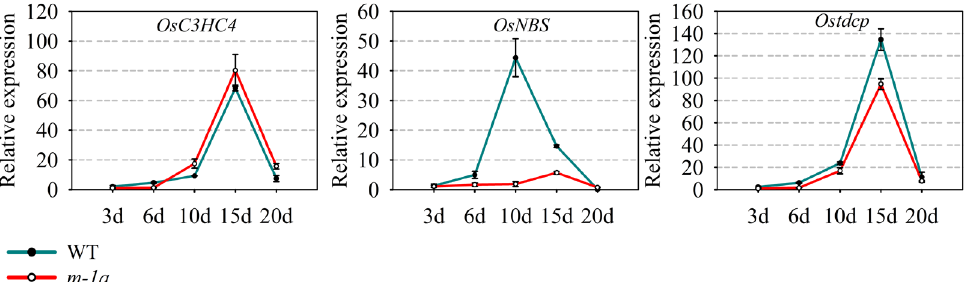
Figure 8. Expression profiles of 3 rice genes during development of Zhonghua 11 (wild type) and the m-1a strain. The gene expression in the 3-d endosperm of wild-type rice was used as a control. d = days after pollination; WT = wild type. Values represent the mean ± SD of triplicates.